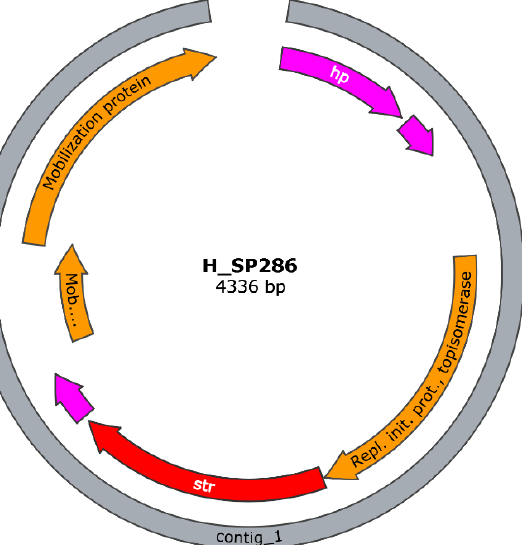
Figure 4. Visualization of the contig harboring str in H_SP286. The red arrow indicates the antibiotic resistance gene str; in pink, hypothetical proteins; in orange, genes related to mobilization and rep- lication.